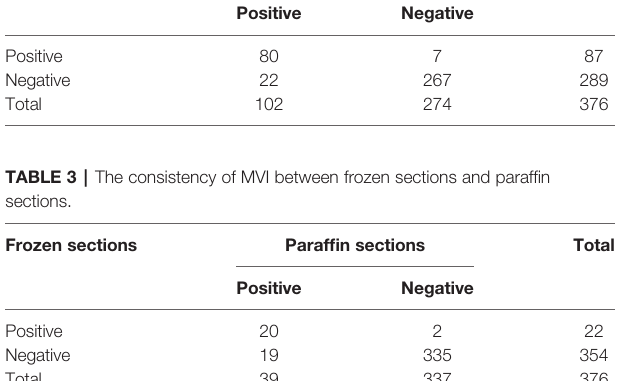
TABLE 2 | The consistency of the presence of micropapillary/solid subtype between frozen sections and paraf fi n sections. Frozen sections